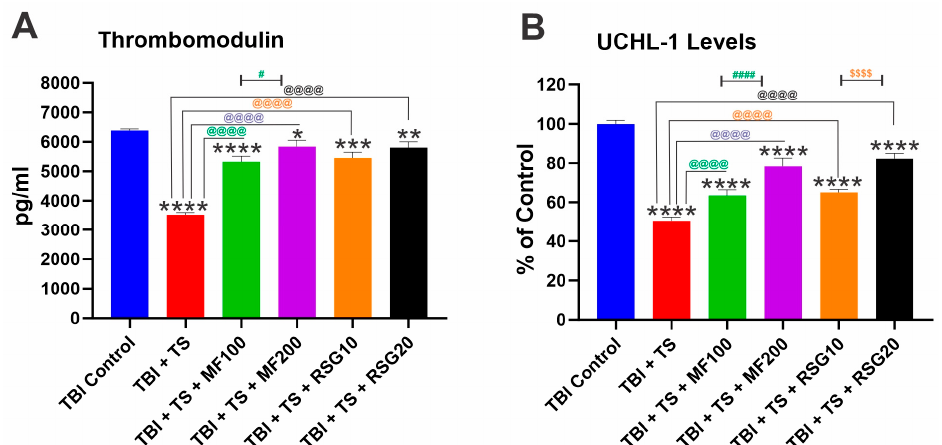
Figure 7. MF and RSG recover the reduced plasma level of Thrombomodulin and UCH-L1 in premorbid TS-exposed and TBI-induced mice. ELISA measurement of ( A ) UCH-L1 and ( B ) Thrombomodulin levels in the blood samples collected 7 days after TBI. n = 6 biological replicates, * p < 0.05, ** p < 0.01, *** p < 0.001, **** p < 0.0001 versus control. @@@@ p < 0.0001 non-treated versus MF/RSG-treated group. # p < 0.05, #### p < 0.0001 MF100 versus MF200. $$$$ p < 0.0001 RSG10 versus RSG20.